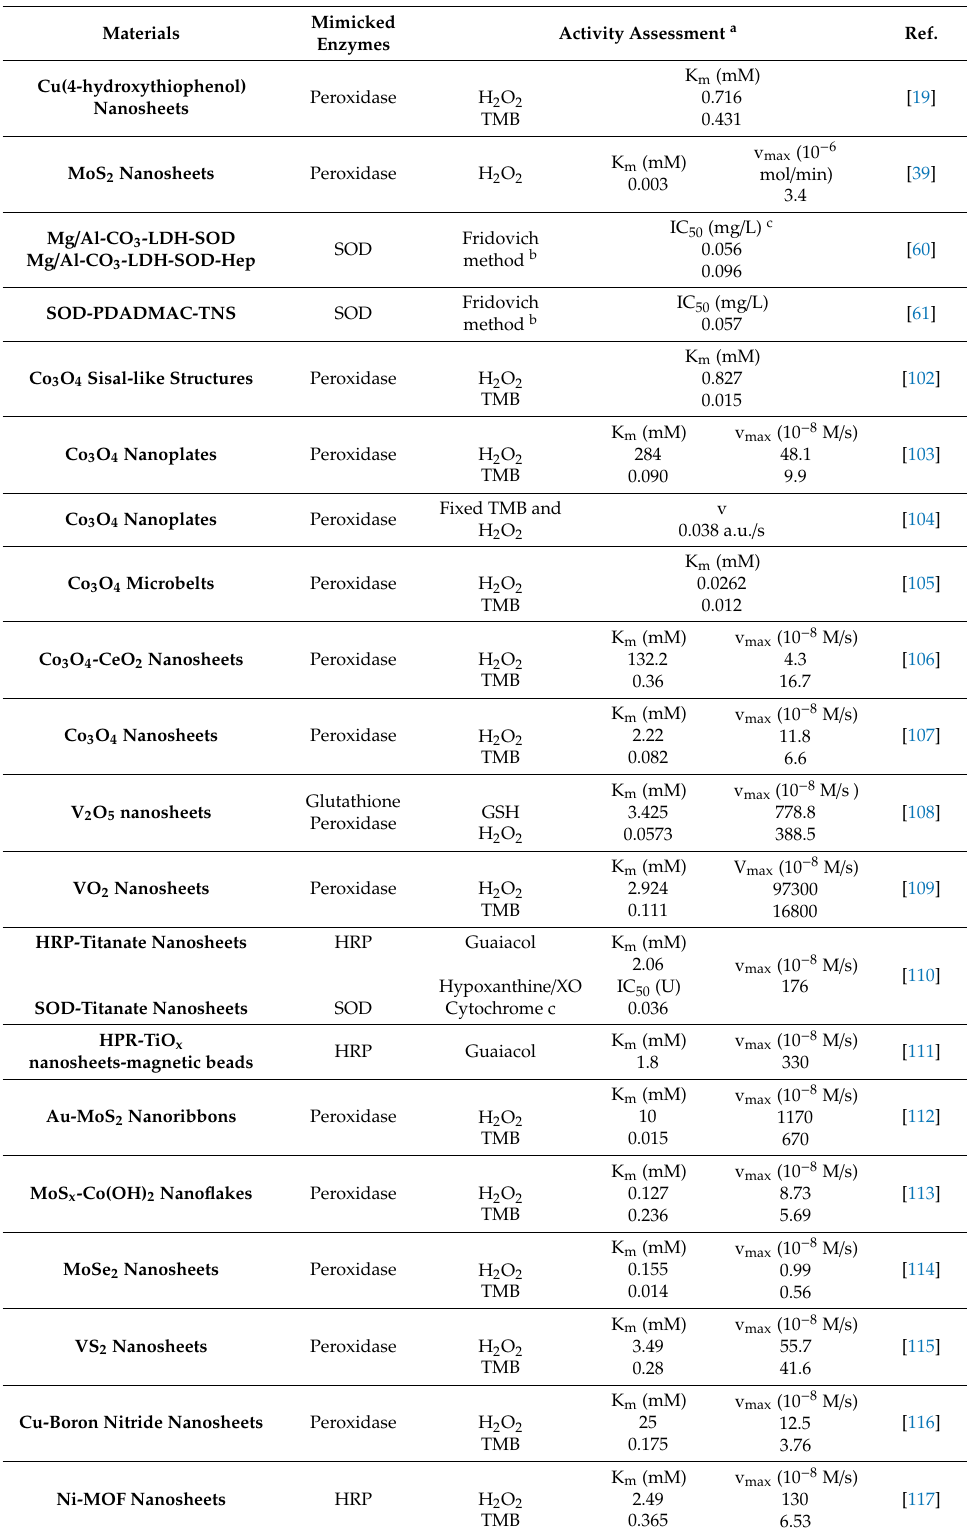
Table 1. Two-dimensional 2D nanomaterials of antioxidant properties and the quantitative assessment of their activities in test